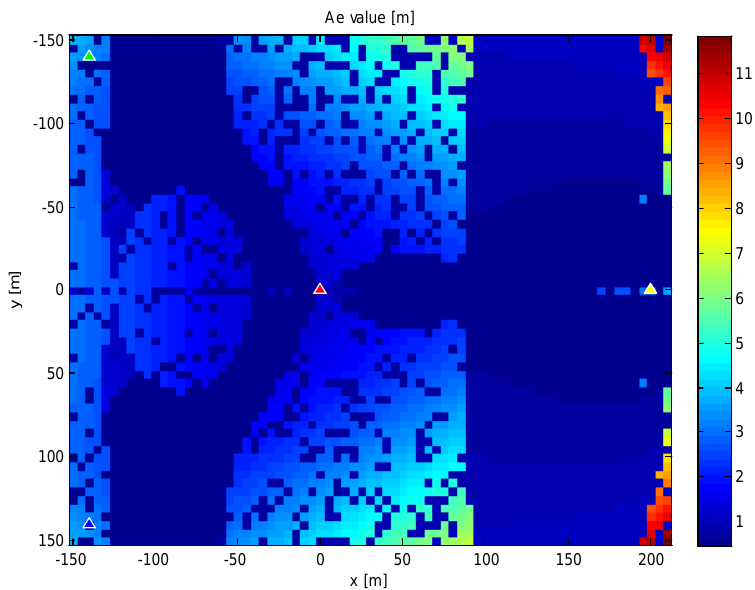
Figure 3. The values of the A e parameter.